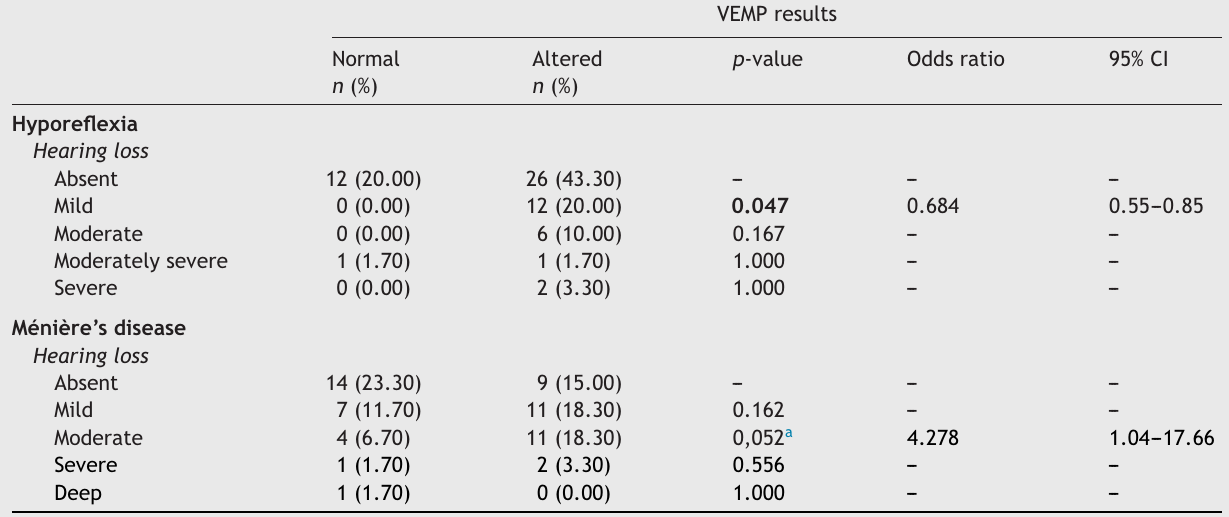
Table 5 Comparison of the degree of hearing loss, per ear, in vestibular hyporeflexia and Ménière’s disease in relation to the outcome of combined cervical and ocular VEMP ( n =